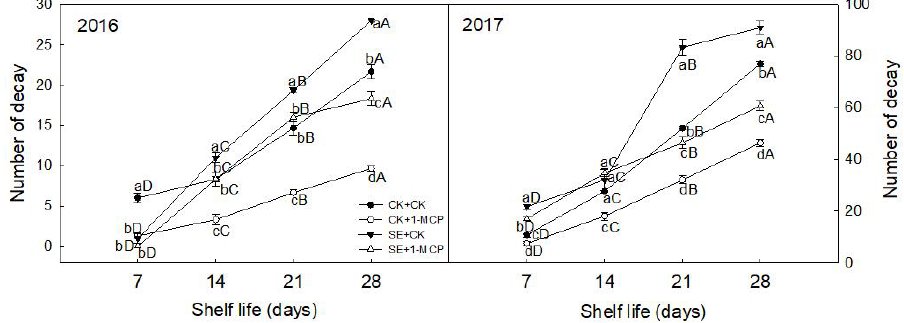
Figure 2. The decay number of grapes during shelf life period. Notes: CK—control treatments; SE—Se fertilizer treatments; 1-MCP—1-Methylcyclopropene treatments. Different lower-case letters on the polyline show significant differences ( p < 0.05) between different treatments. Different capital letters on the polyline show significant differences ( p < 0.05) between different shelf life (days).